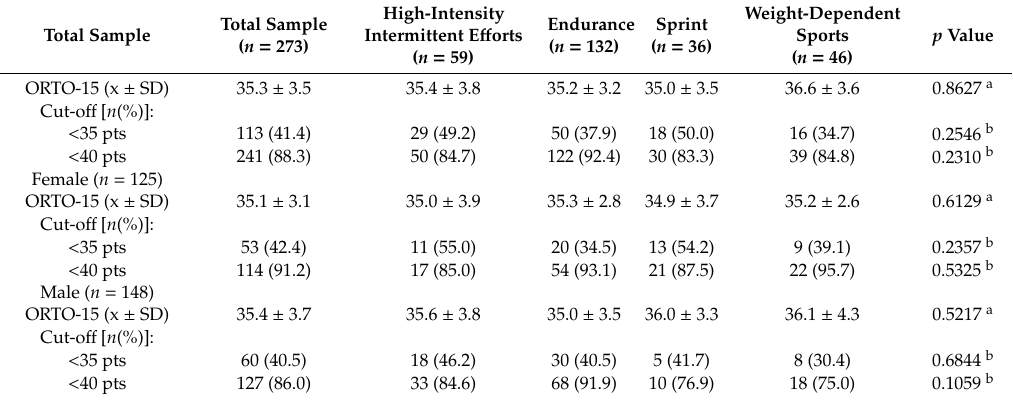
Table 3. Sample mean ORTO-15 score and prevalence of scores below fixed cut-o ff value of 35 or 40 points including sex and type of e ff ort.